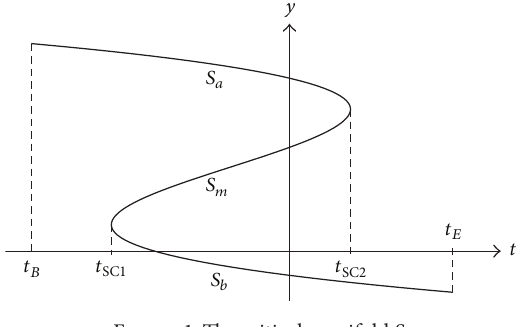
Figure 1: The critical manifold 𝑆